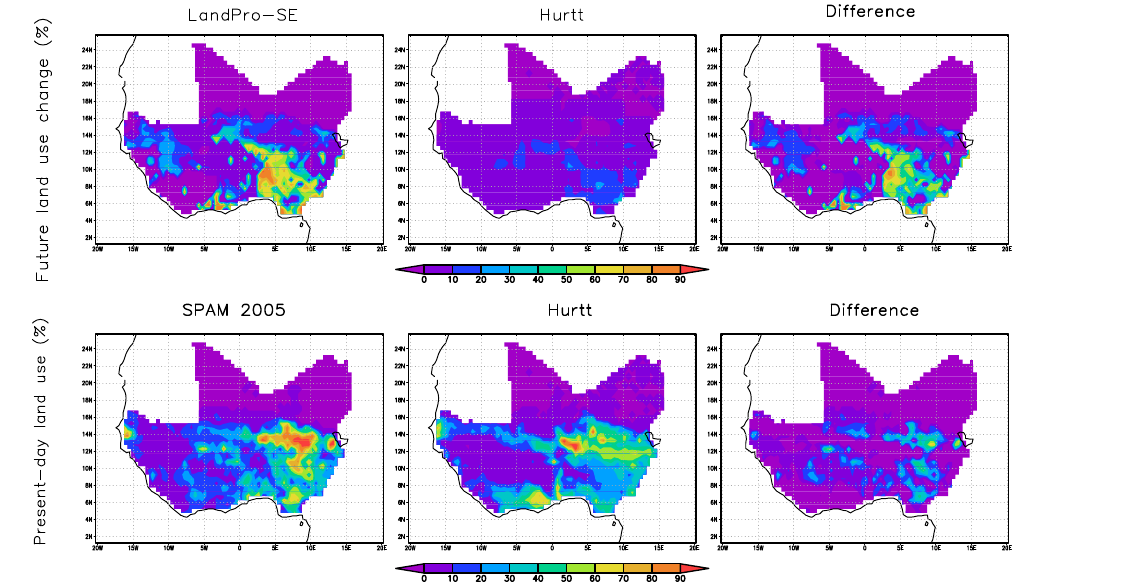
Figure 9. Future changes in crop area distribution, from the LandPro projections accounting for only socioeconomic changes (LandPro_SE) and from the Hurtt et al. (2011) data, and their differences (top row panels); the present-day (2005) crop area, from SPAM and from Hurtt et al. data, and their differences (bottom row